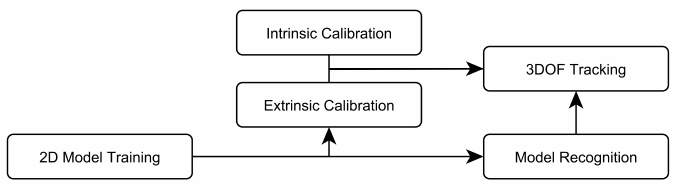
Figure 2. Overview over the system’s workflow.